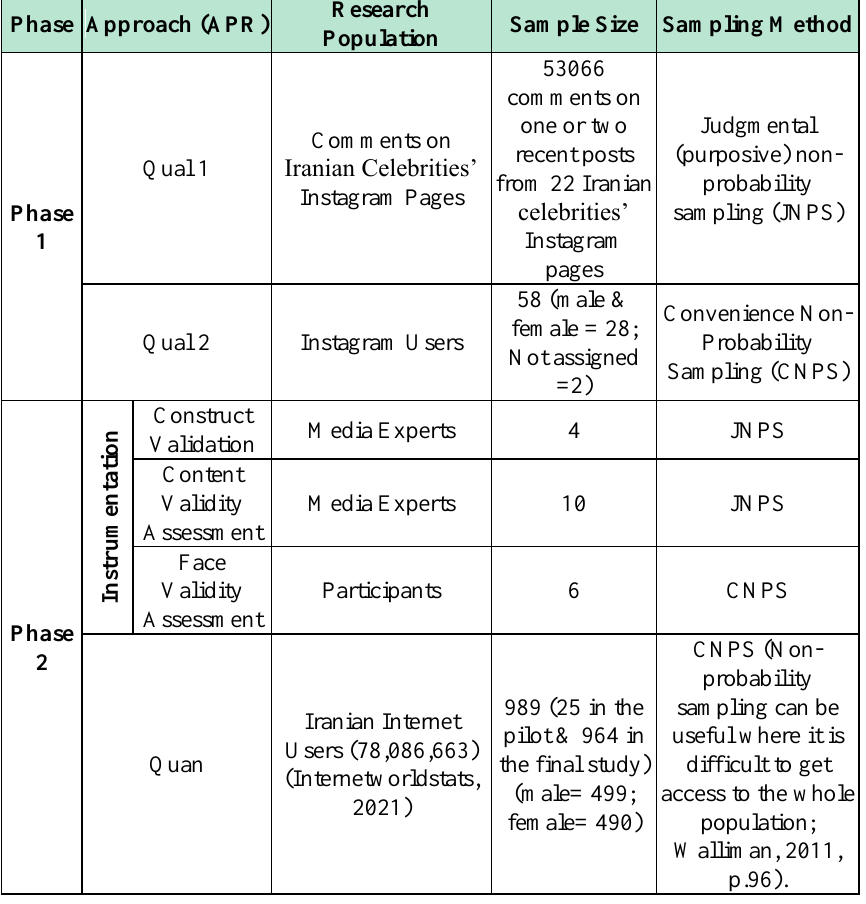
Table 1: Research Populations, Sample Sizes, and Sampling Methods Phase Approach